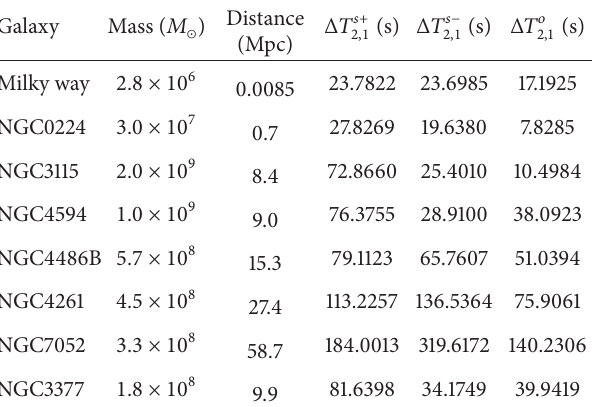
Table 5: Estimation of time delays of the supermassive BHs located at the center of galaxies for ordinary global monopole ( 𝜉 = 1 ) with 𝜂 = 0.05 .